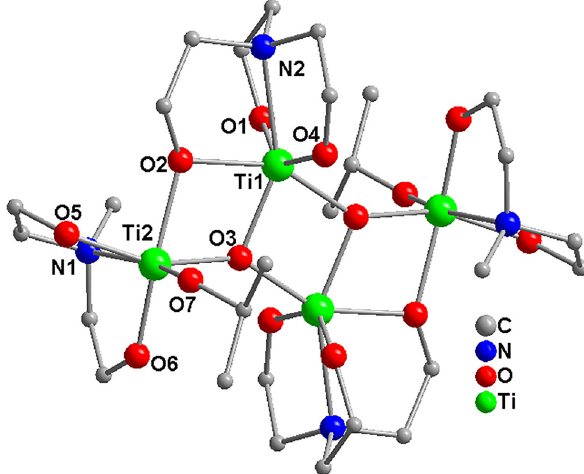
Table  : Data collection and